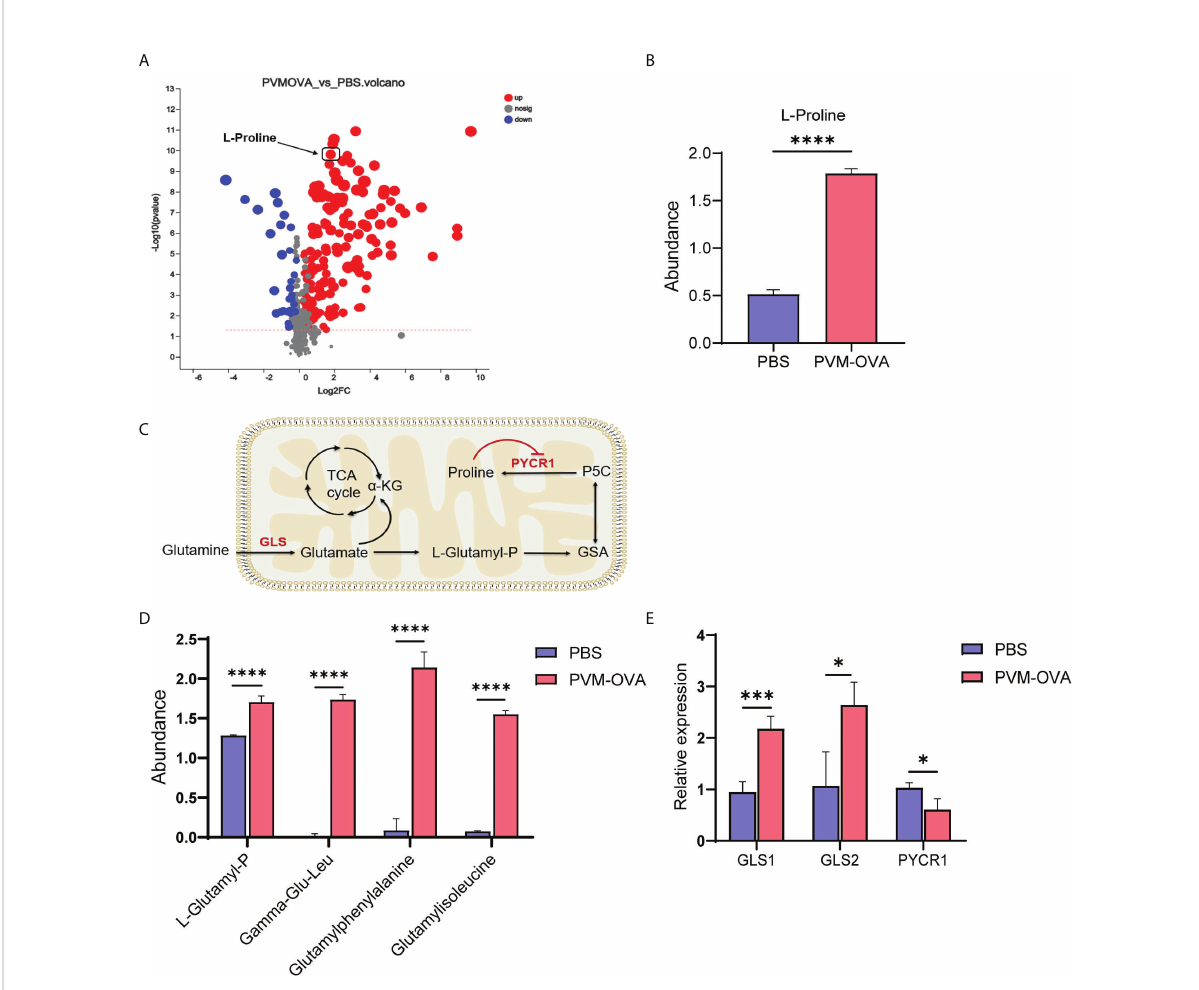
FIGURE 4 Proline metabolism in mice sensitized with PVM-OVA was signi fi cantly reprogrammed. (A) Volcanic map of differential metabolites of PVM-OVA group vs PBS group. (B) The abundance of proline. (C) Diagram of proline synthesis pathway from glutamine. (D) The abundance of dipeptide containing glutamic acid. (E) Relative expression of enzymes, GLS1, GLS2 and PYCR1, in the synthesis pathway of proline in the lung by real-time PCR. Each experimental group contained three biology repeats. *P<0.05, ***P<0.001,